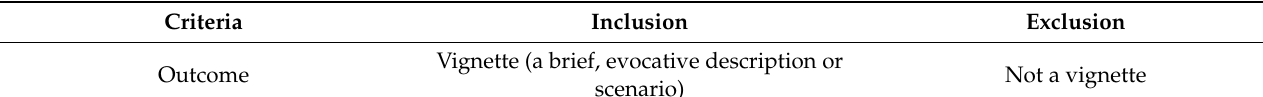
Table 1. Inclusion and exclusion criteria for screening search